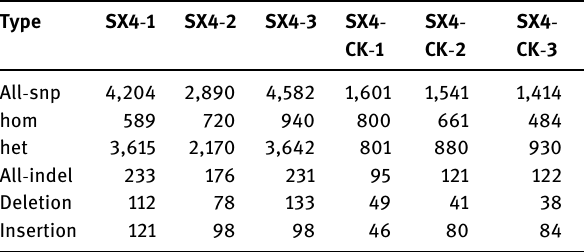
Table 2: Analysis of SNP in two treatments ( SX4 and SX4.CK )